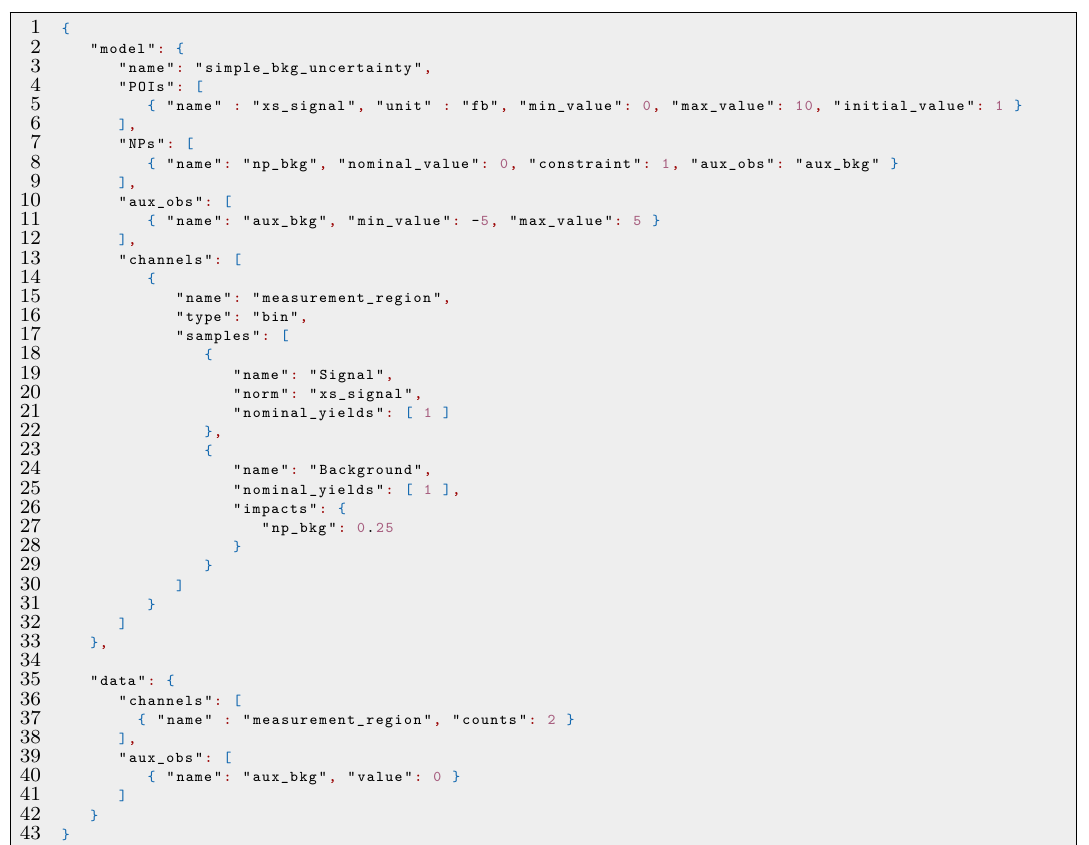
Figure 1 . Specification for the example SLLS model described in the